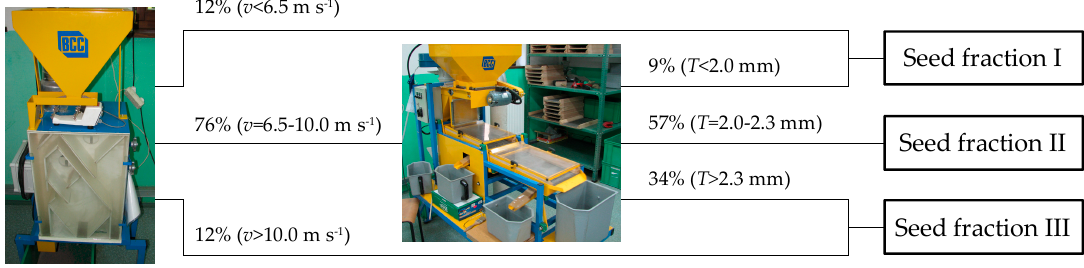
Figure 3. Process of sorting black pine seeds. Table 4. Process of sorting black pine seeds into fractions with a pneumatic separator and a mesh sieve. Proportion (%) of Coe ffi cient of Variation Seed Fraction Percentage (%) (%) of Seed Mass